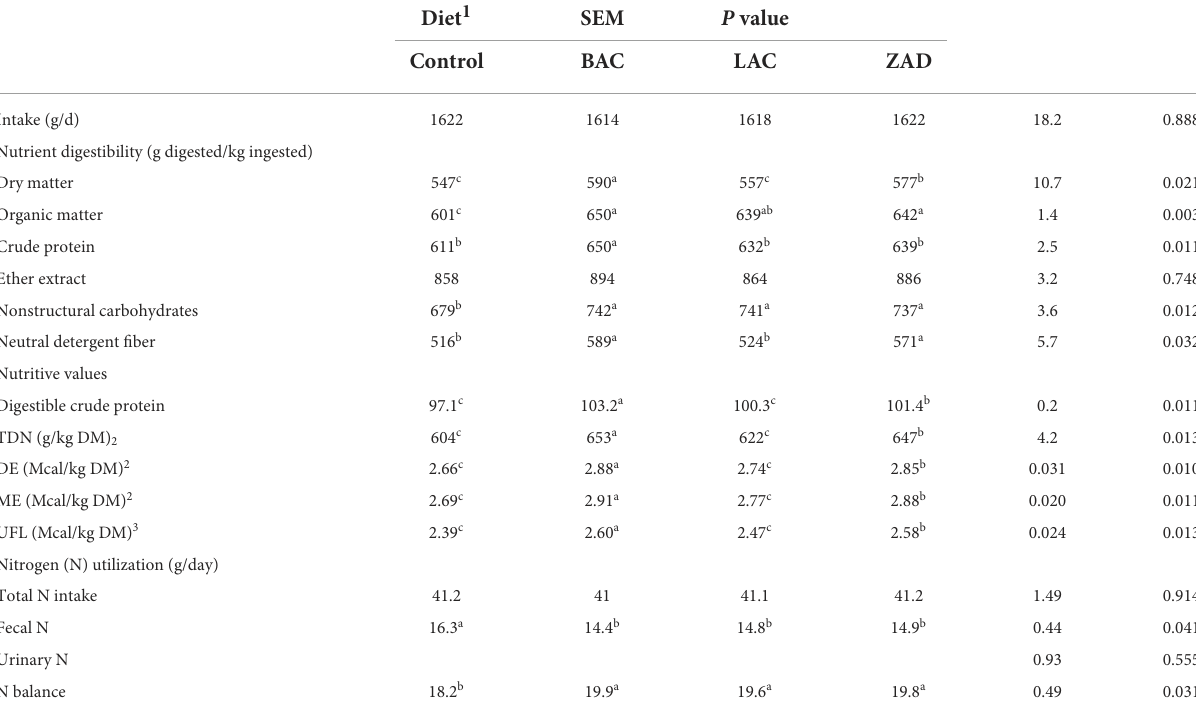
TABLE 6 Feed intake, nutrient digestibility, diet nutritive values and nitrogen (N) balance of adult Farafra rams fed with diets containing date palm leaves treated with different probiotics. Diet 1